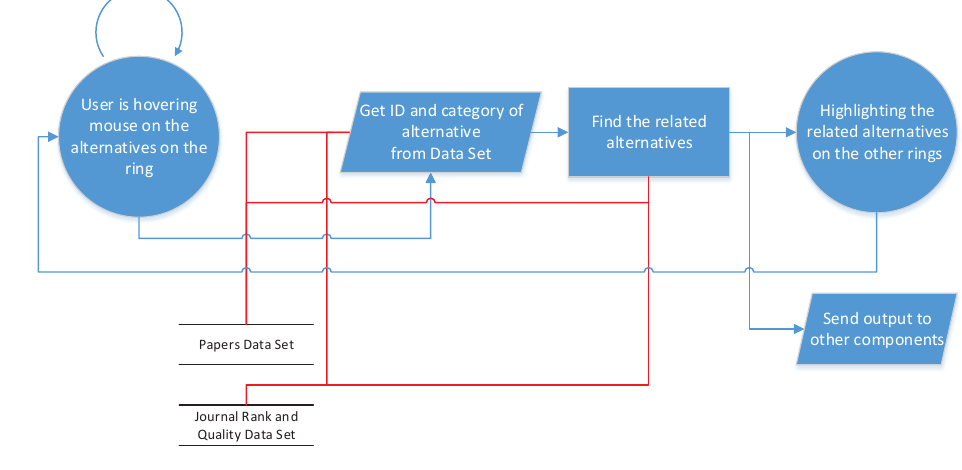
Figure 8. Overview step when a journal has been